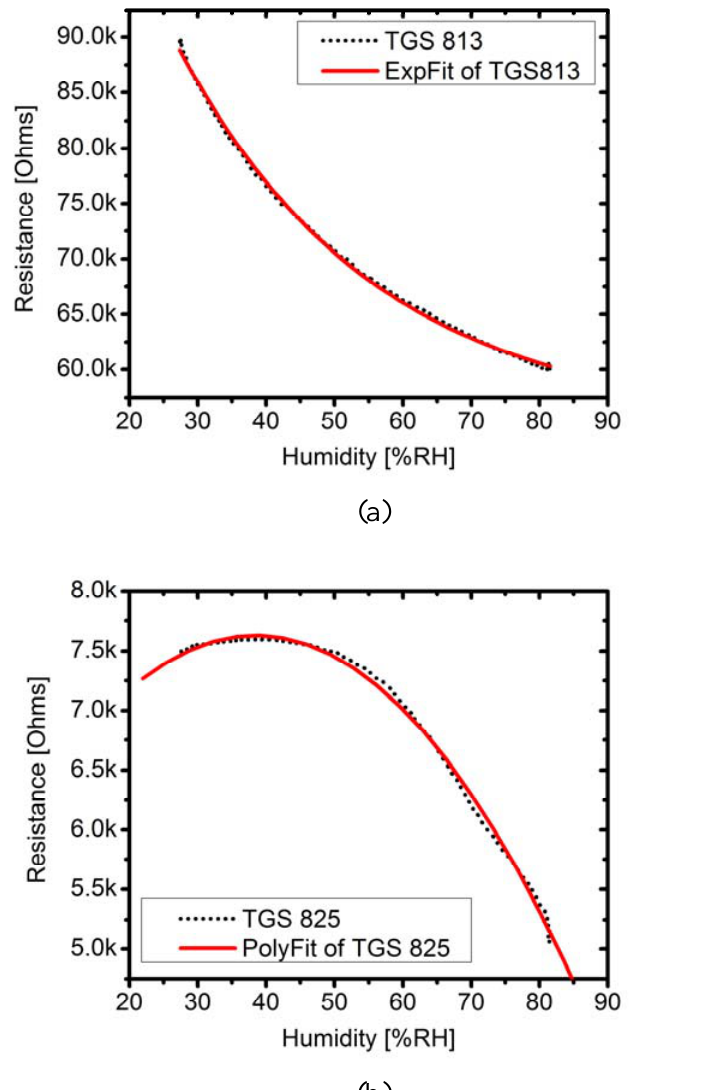
Figure 4. Resistance of sensors (a) TGS 813, (b) TGS 825 and (c) TGS 2602 versus relative